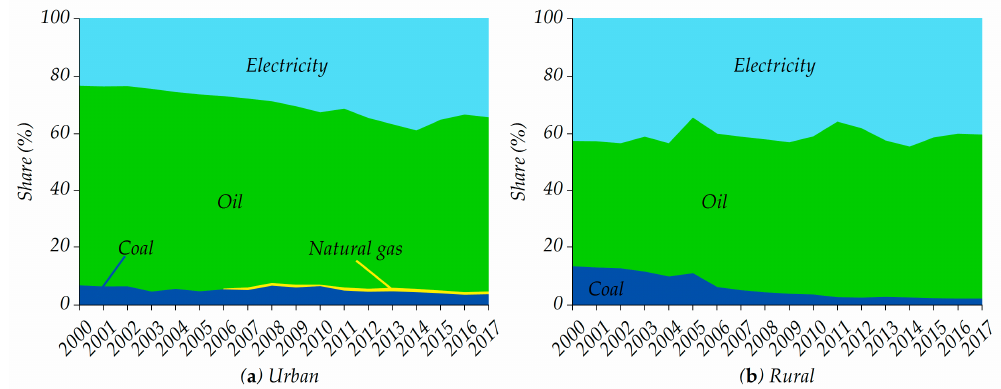
Figure 3. Trends of the energy structure of REC in urban and rural Guangdong during 2000–2017. ( a ) Urban. ( b ) Rural.